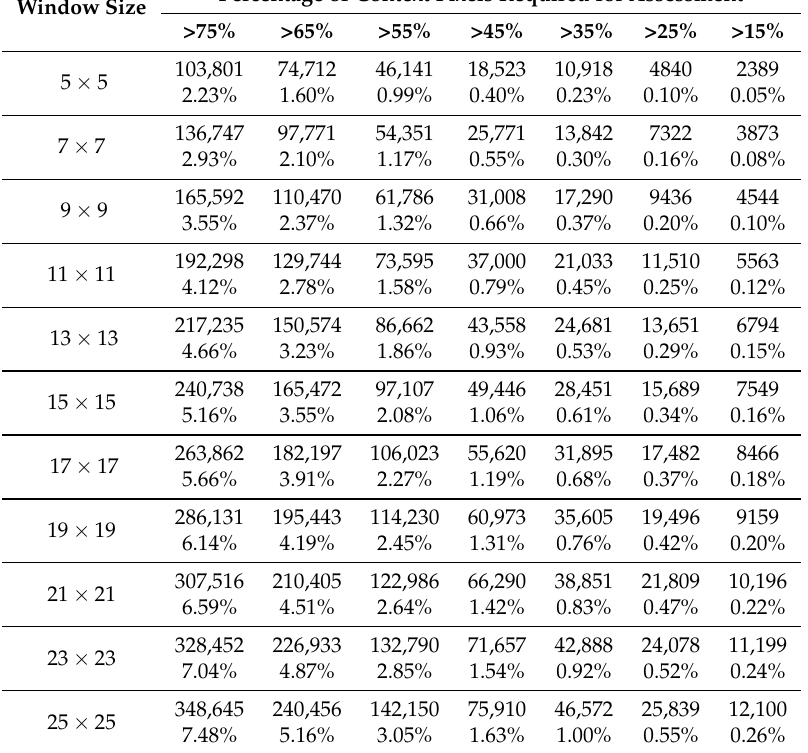
Table 3. Number and percentage of pixels that are lacking sufficient adjacent pixels to provide contextual estimation at various window sizes and percentages across the AHI disk. A total of 4,663,165 AHI land pixels were evaluated.